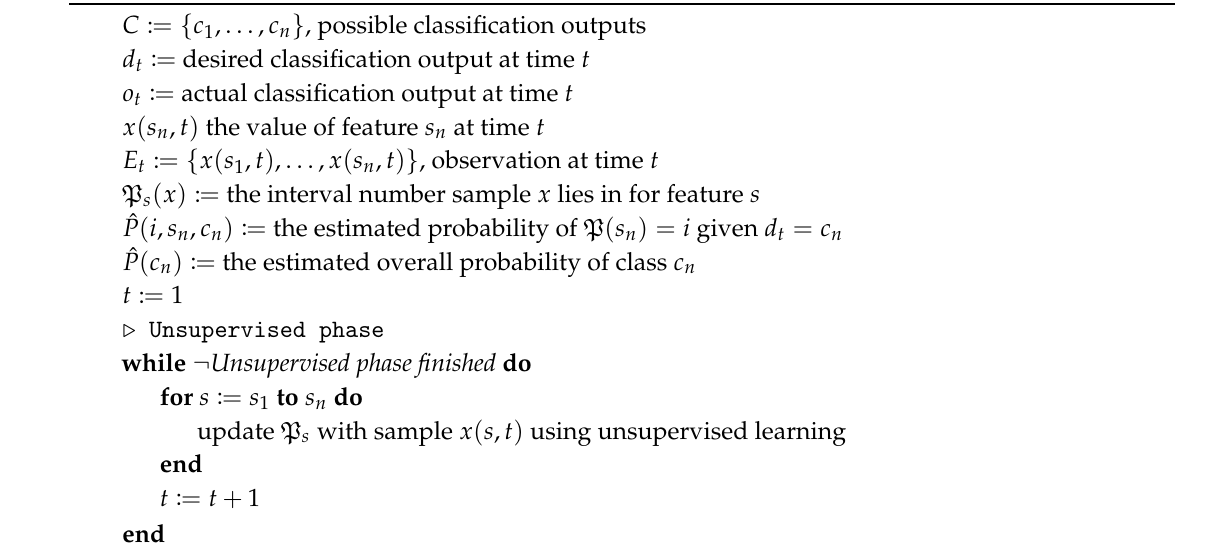
Algorithm 1: Naive Bayes based on unsupervised